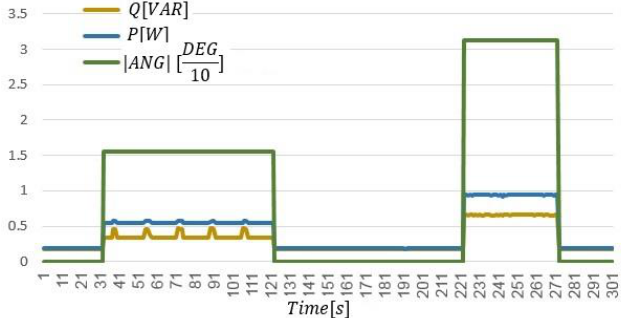
Figure 8. Feature graph of Light 1 and Light 2, which are difficult to disaggregate with two features but easily disaggregated with three. P is active power, Q is reactive power, and ABS(ANG) is absolute phasor current angle.